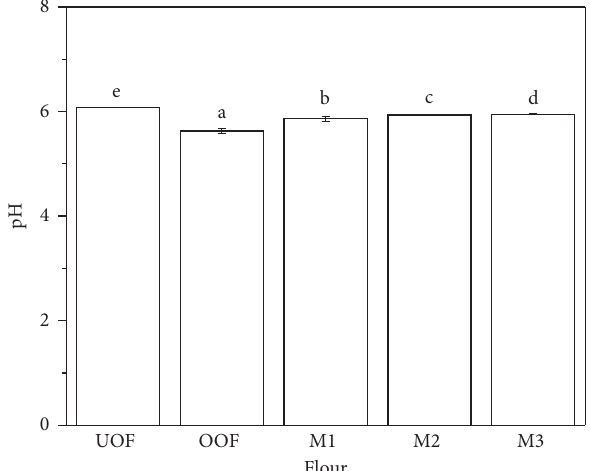
Figure 1: pH values of wheat flour added with different ratios of overozonized wheat flour. Means with the same letter were not significantly different ( α � 0.05).